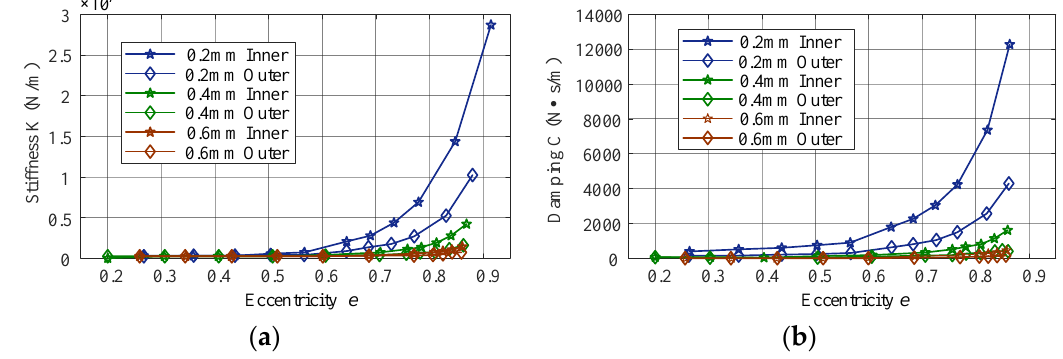
Figure 10. Typical stiffness and damping curves: ( a ) stiffness ( b ) damping. Under the condition of high speed and large unbalanced mass, such as r n = 12,800 r/min, which is higher than the second-order critical speed, m e = 4 × 10 − 4 kg · m, the calculated rotor vibration response is shown in Figure 11.